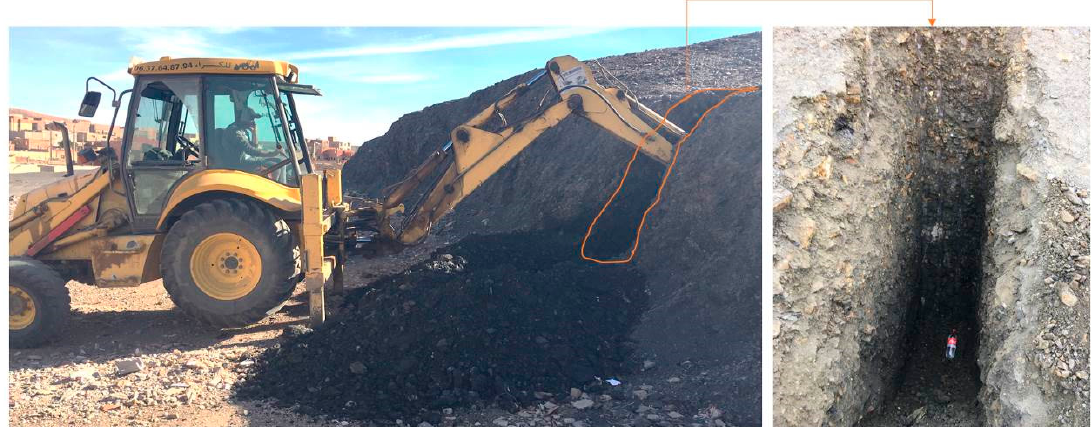
Figure 2. Coal mine waste rocks (CMWR) sampling with a loader machine.